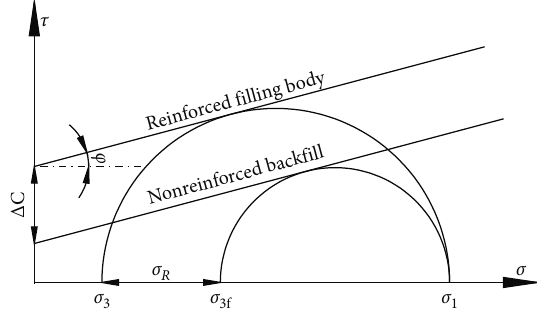
Figure 11: Under the same normal stress condition, the shear strength and lateral stress changes of